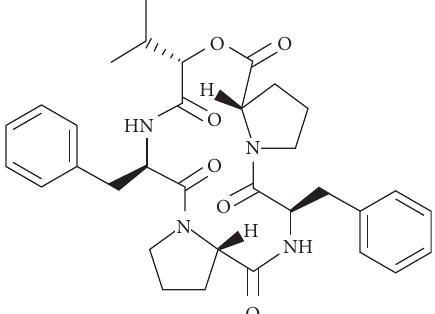
Figure 1: Graphical sketch of the molecular structure of the alternaramide marine